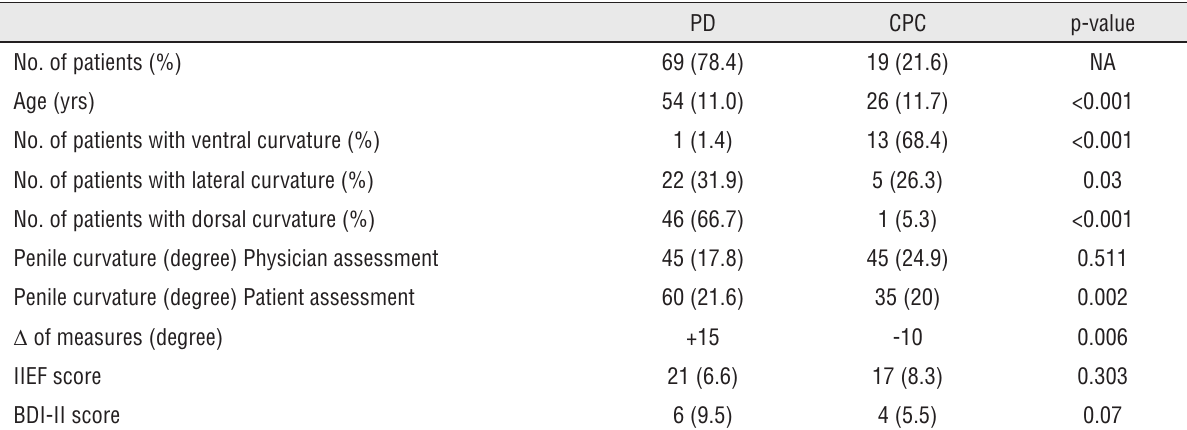
Table 2 - Descriptive statistics of the whole cohort of patients [media (SD)].